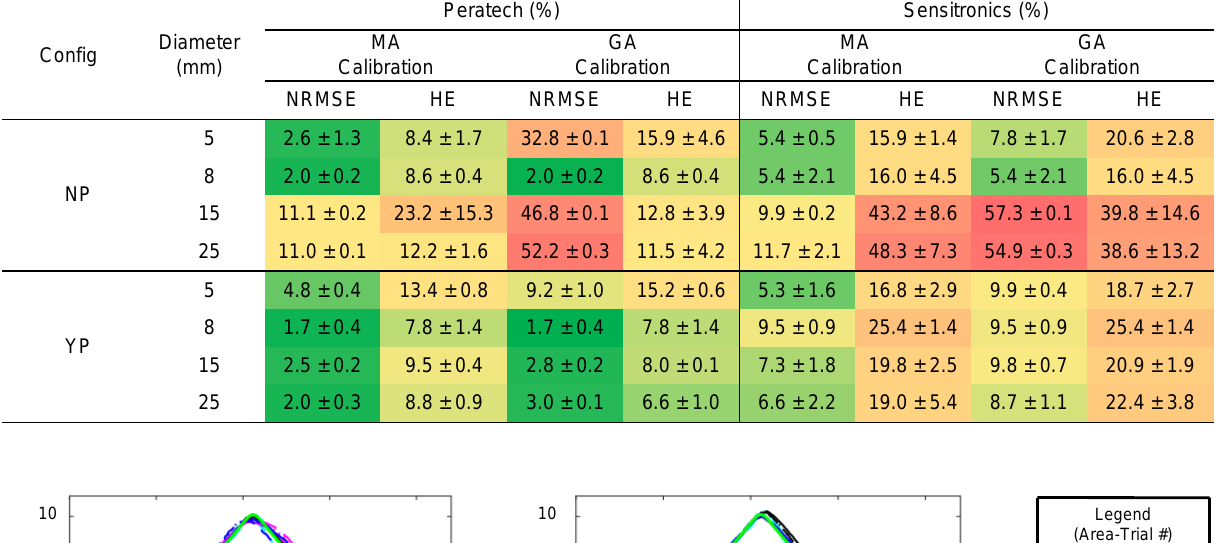
Legend (Area-Trial